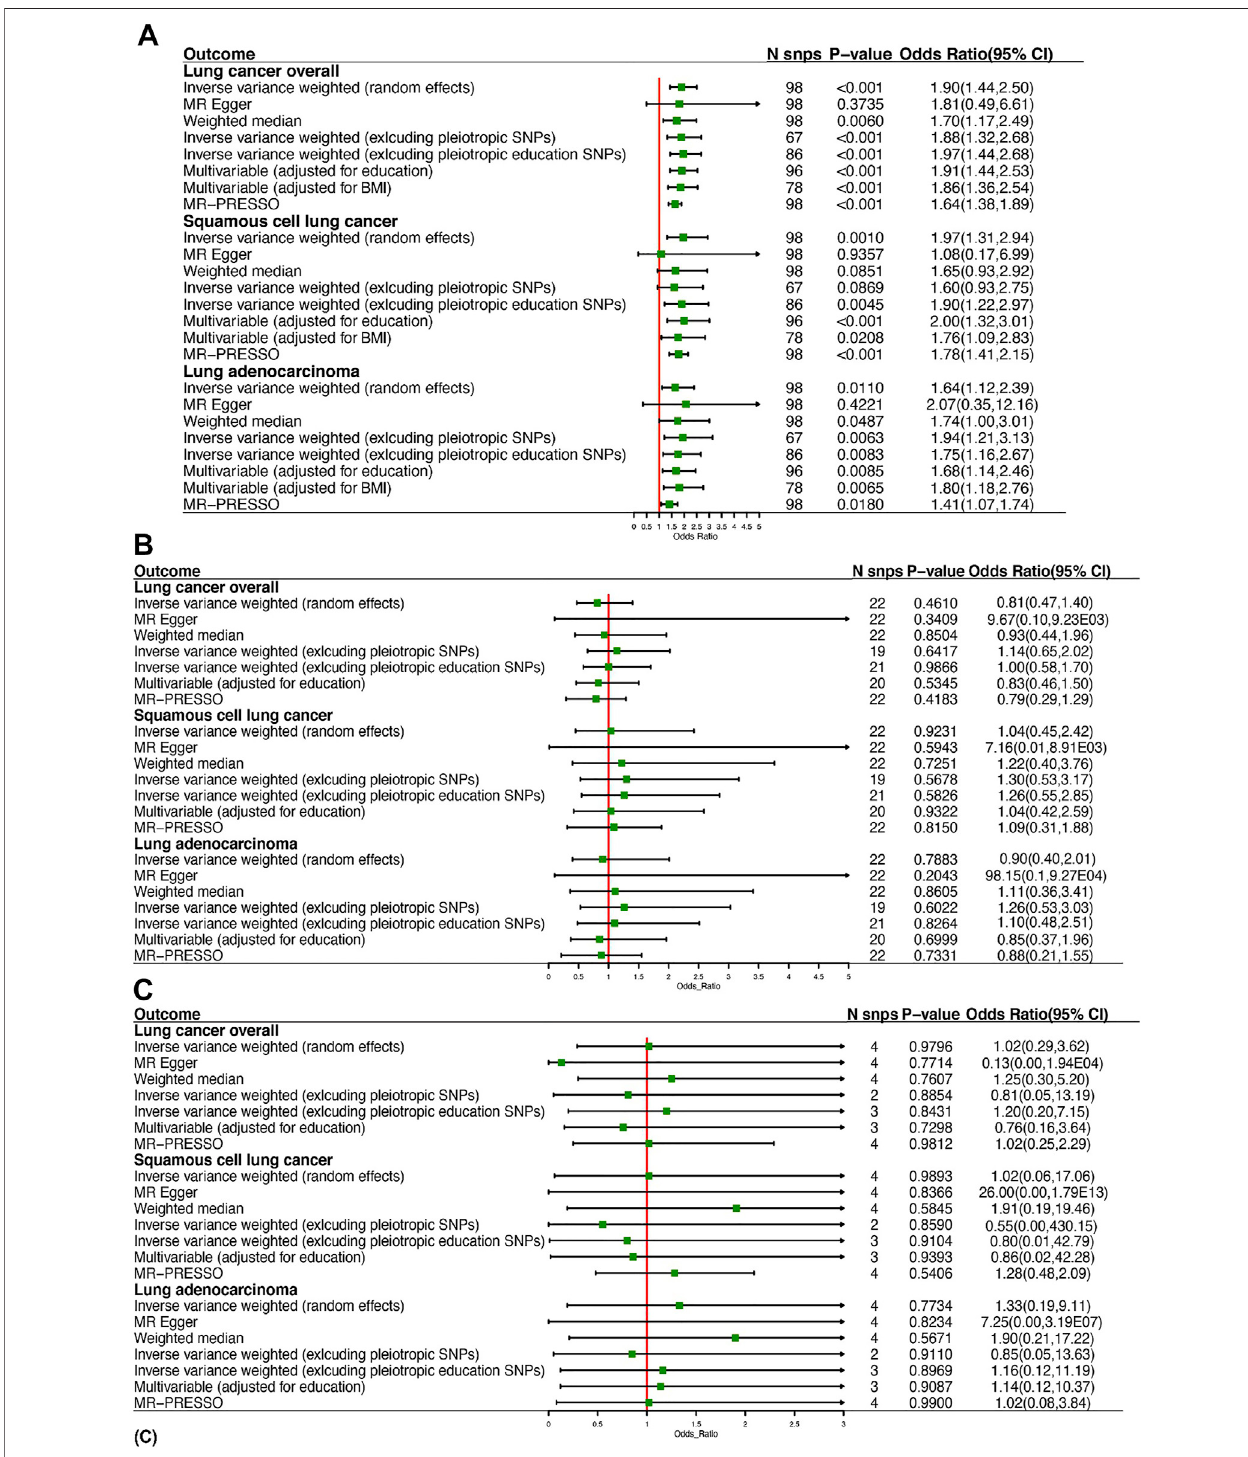
FIGURE 2 | Summary of Mendelian randomization estimates of leisure sedentary behaviors on the risk of lung cancer: (A) is for watching television, (B) is for computer use, and (C) is for driving.